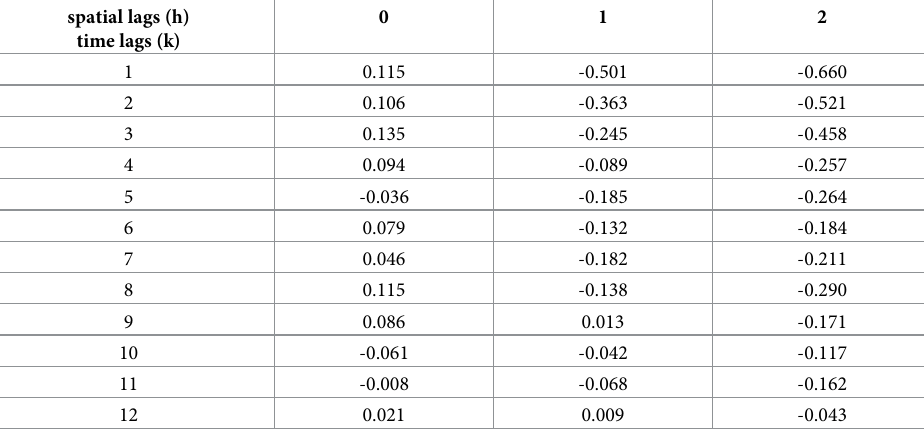
Table 5. Partial Autocorrelation function values of HFRS incidence before seasonal